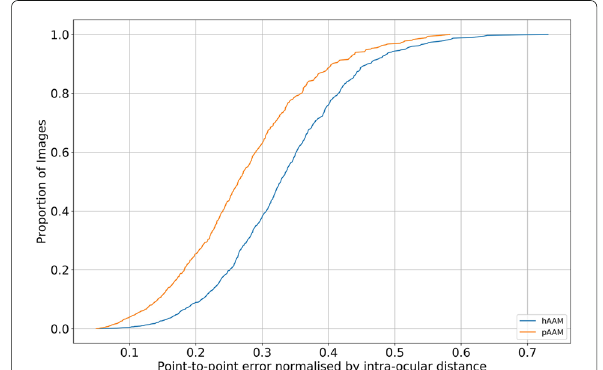
Fig. 14 300W (combined) cumulative error distributions. Comparing the performance of holistic AAMs, patch AAMs, and the performance reported by Yan et al. [48], Zhou et al. [58], and Milborrow et al. [72]